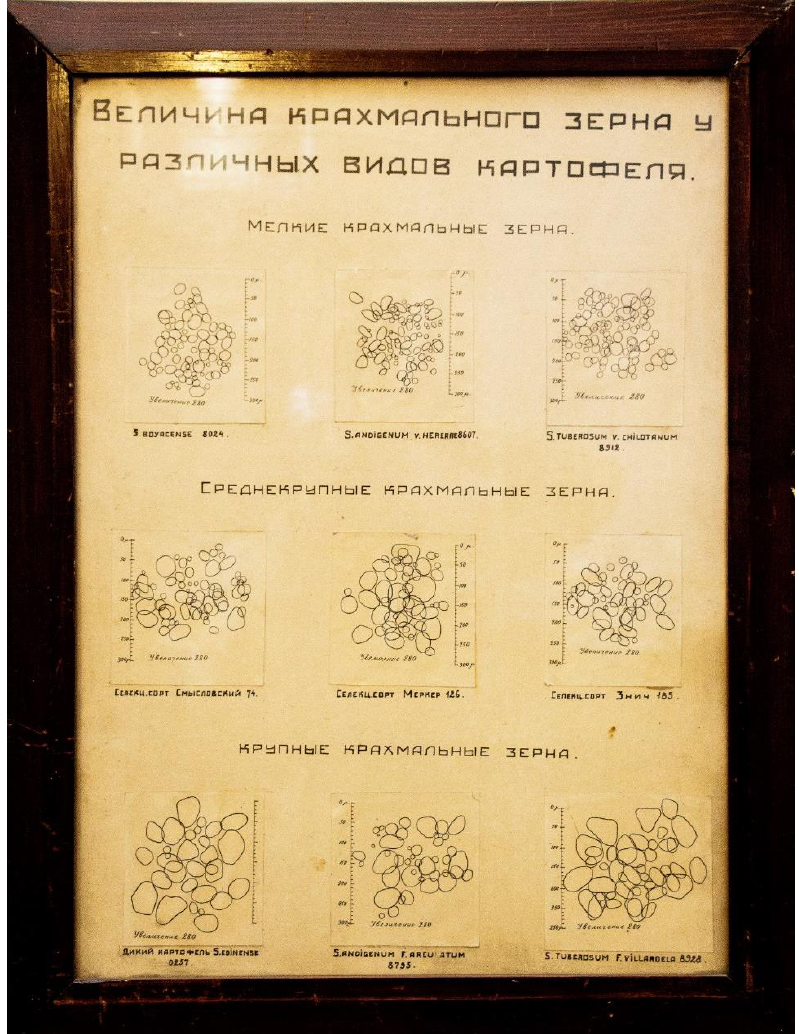
Figure 1. Hand-drawn table entitled “Starch granules size of various potato varieties”. Located in Vavilov memorial room of the N.I. Vavilov All-Russian Research Institute of Plant Genetic Resources (VIR), St. Petersburg, Russia.